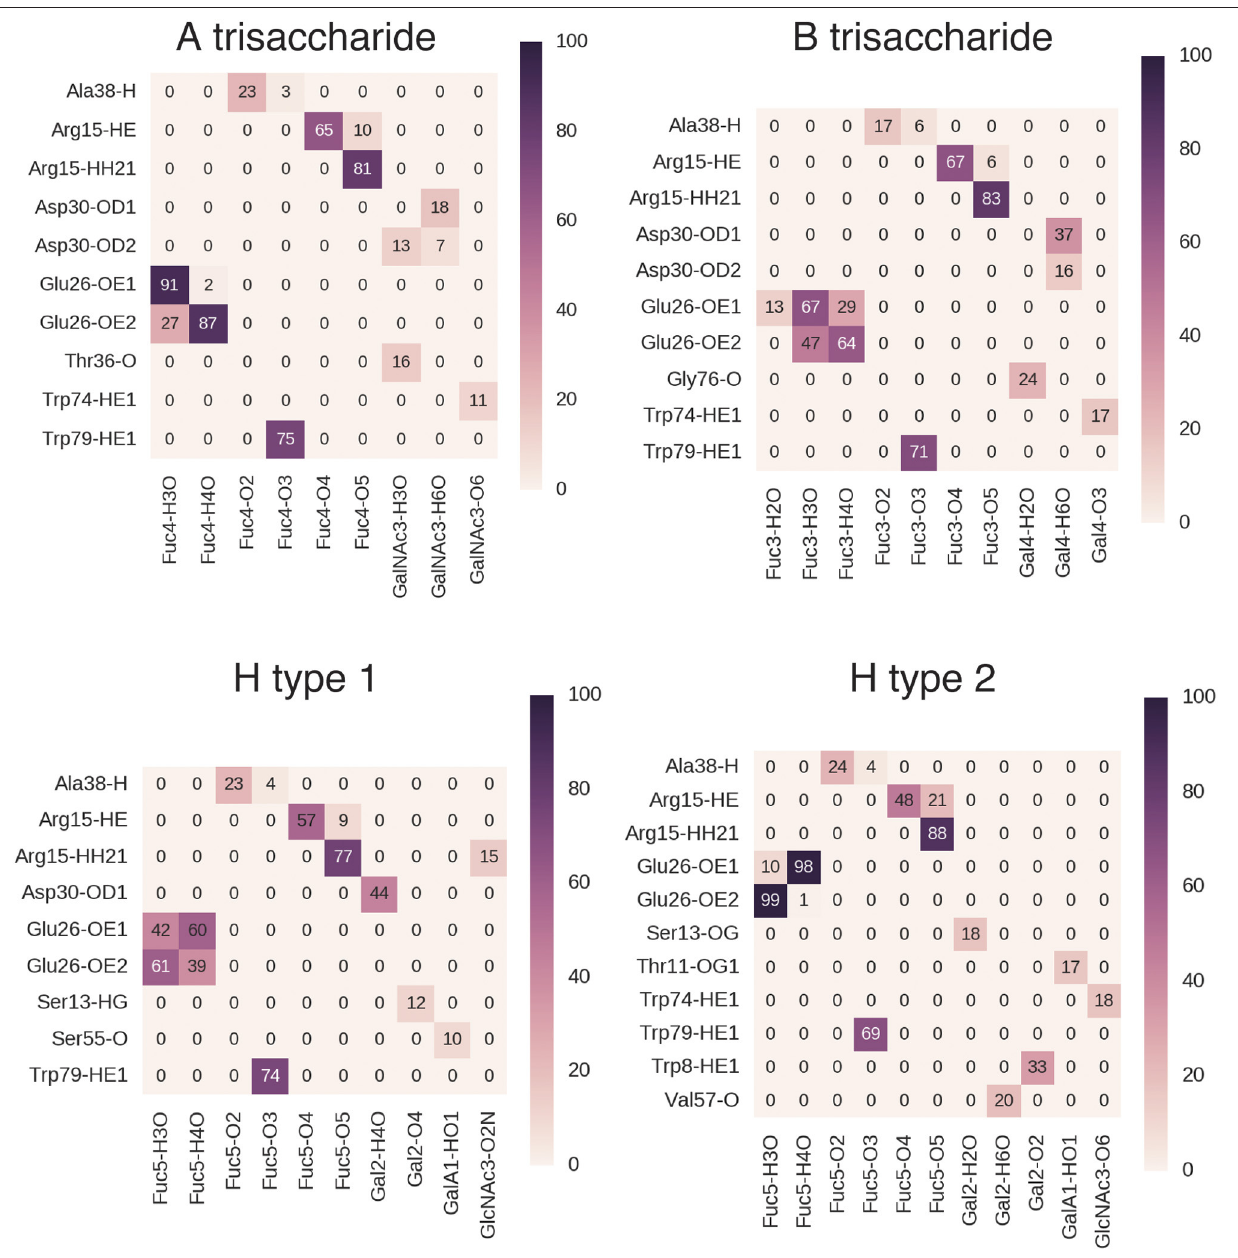
( Figure 7 ). As observed in docking, the Fuc α 1-2Gal linkage